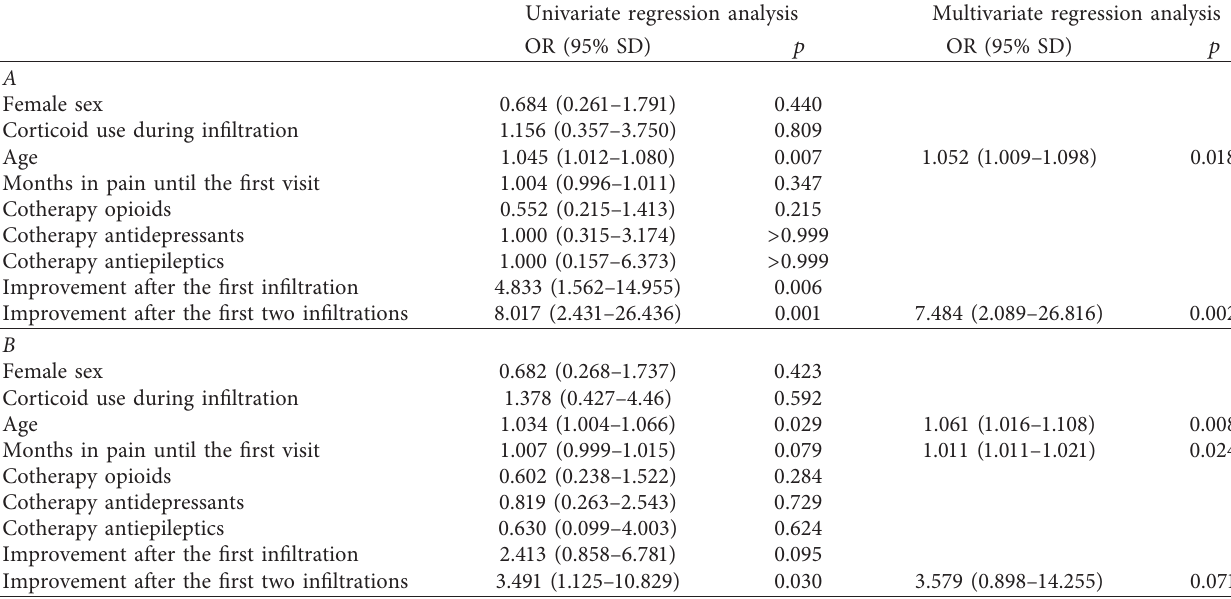
Table 2: Logistic regression